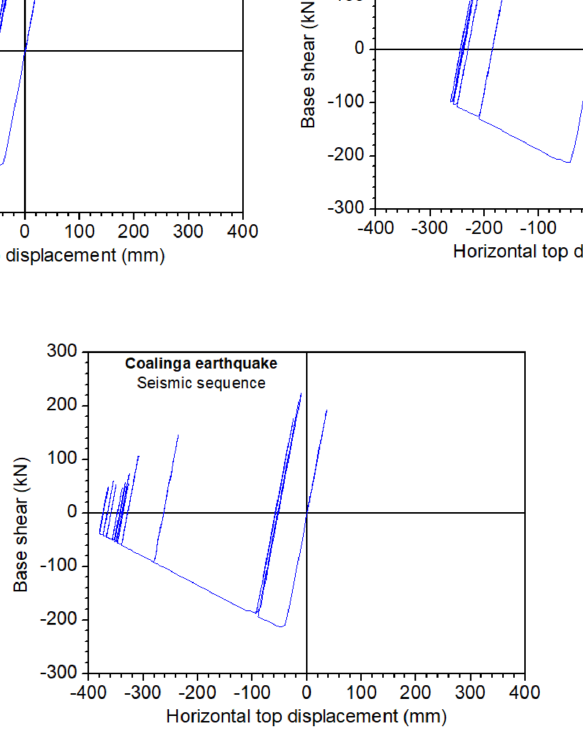
Figure 11. Fixed-base platform under the Coalinga earthquake (22 and 25 July 1983): single seismic events vs. seismic sequence.